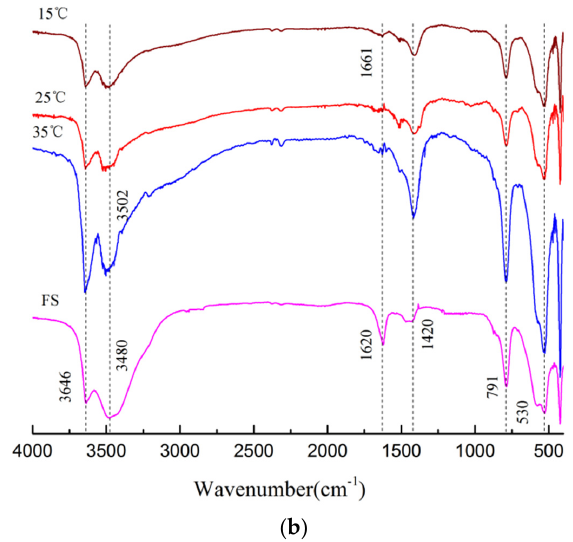
Figure 8. FT-IR spectra of solidification products at different pH conditions and temperatures. ( a ) FT-IR spectra of solidification products under different pH conditions at 25 °C. ( b ) FT-IR spectrum of solidification products at different temperatures at Ph = 11.